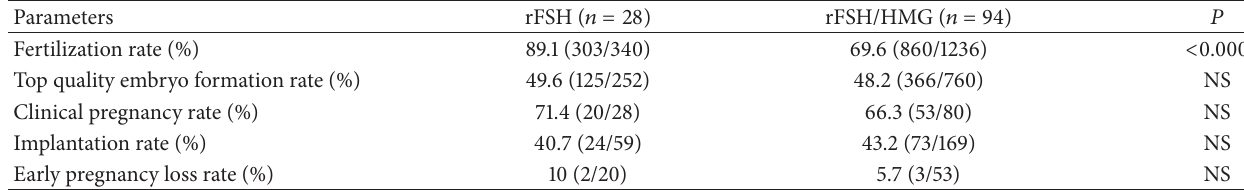
Table 3: Outcomes of this IVF/ICSI